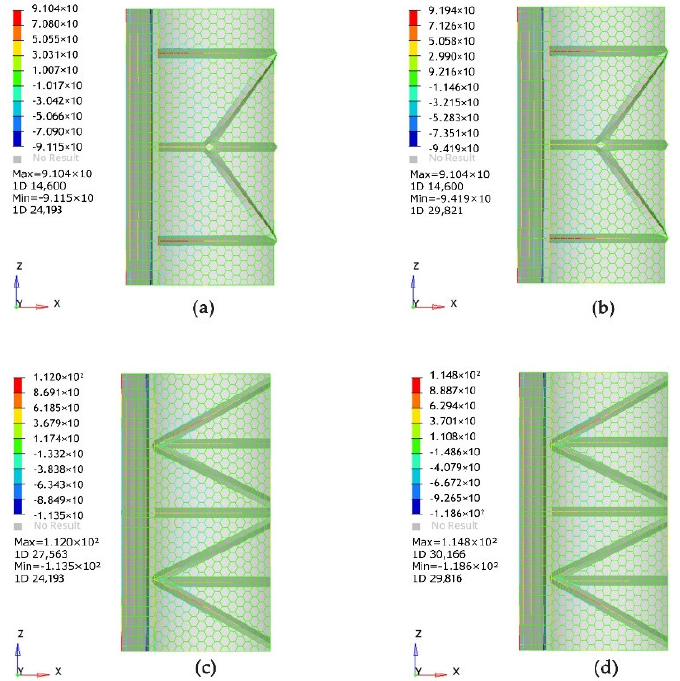
Figure 15. ( a ) Linear stress analysis of the carport I model under the load of 1.2 G K + 1.4 Q W ; ( b ) Nonlinear stress analysis of the carport I model under the load of 1.2 G K + 1.4 Q W ; ( c ) Linear stress analysis of the carport II model under the load of 1.2 G K + 1.4 Q W ; ( d ) Nonlinear stress analysis of the carport II model under the load of 1.2 G K + 1.4 Q W .